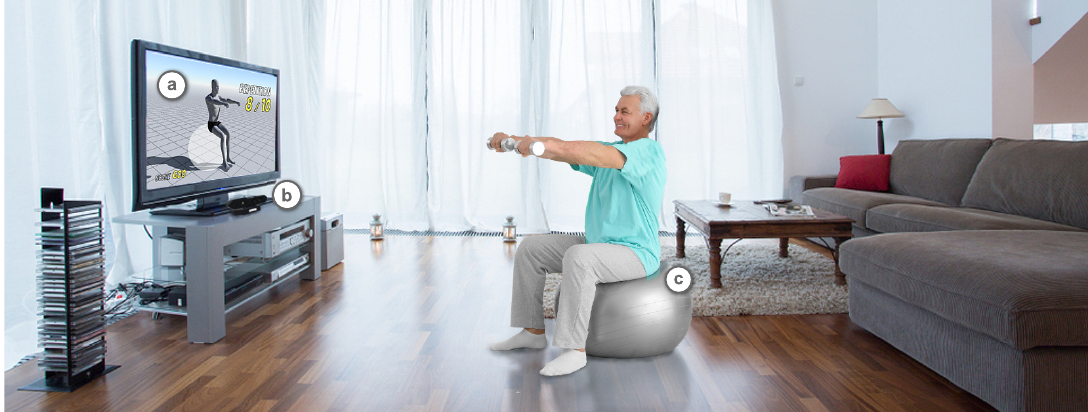
Figure 1. Graphical representation of home environment where patient performs rehabilitation exercises: ( a ) Home TV connected to the device. ( b ) Autonomous device tracking patient skeleton. ( c ) Patient playing